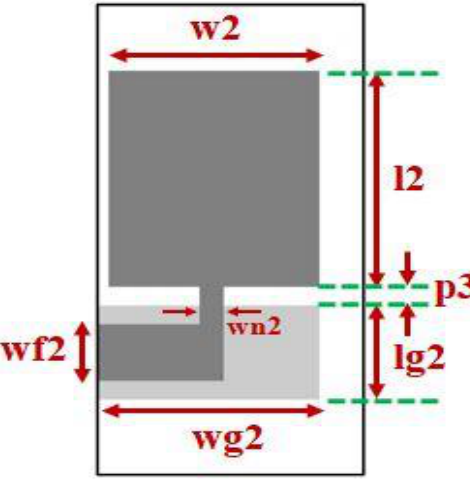
Figure 9. Schematic of the antennas linked with P10 to P17.